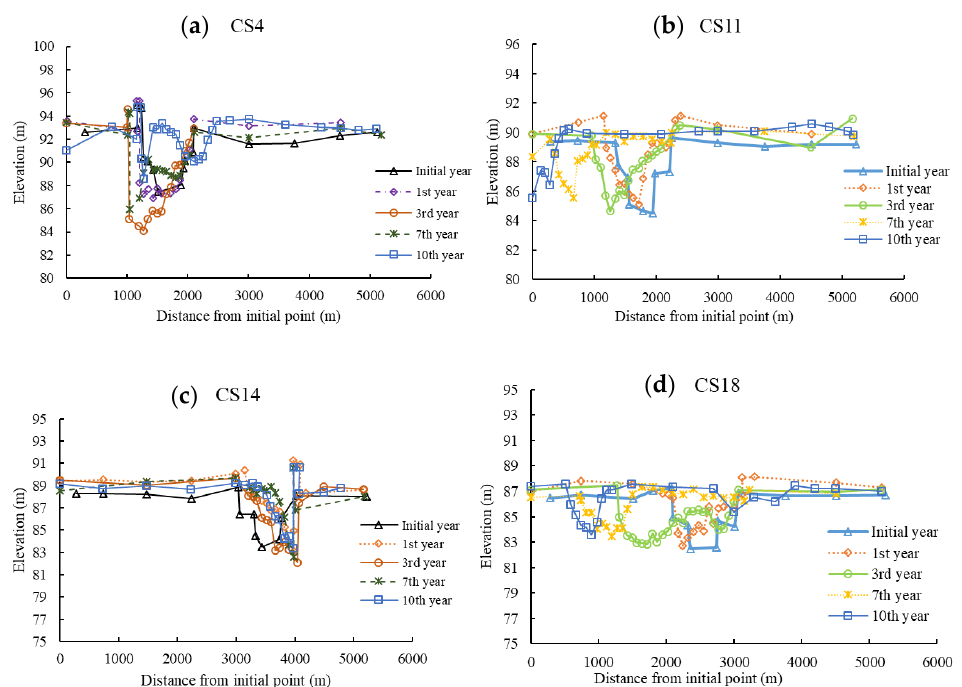
Figure 5. Graphs of different section shapes with four projects: ( a – d ) respectively show CS4 section, CS11 section, CS14 section and CS18 section morphological adjustment in different years.